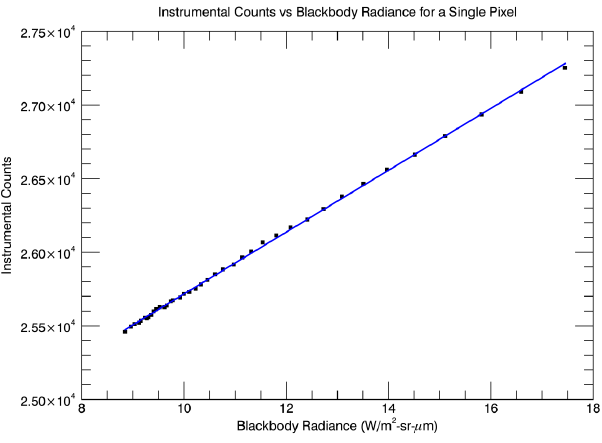
Fig. 4. 10.2–12.2µm instrument response for a single central Figure 4. 10.2-12.2 µm Instrument Response for a single central pixel. 2